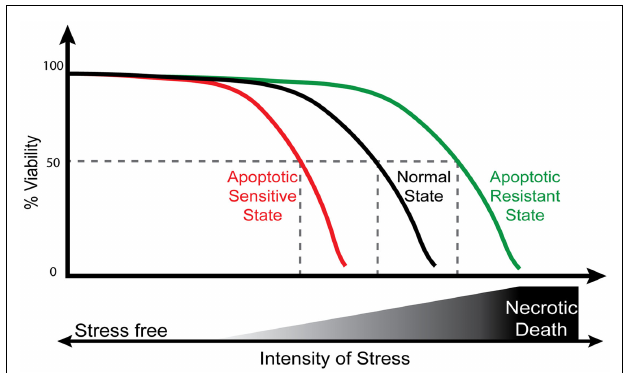
FIGURE 1 | Stress is a dose dependent mediator of cell death. A theoretical and graphical depiction of the effects of increasing the intensity of stress on cellular viability. In a stress free environment cellular viability is maintained close to 100% with only a basal level of cell death. In the normal state (depicted in black), the percentage of cell viability begins to decreases when a specific threshold of stress intensity is encountered. Intensity of stress reflects a combination of time of exposure to the stress and to its intensity. Cell death inducing stresses include a variety of different physical or chemical agents or pathophysiological stresses as discussed in the text. Once the threshold level of stress is encountered, the % viability further decreases in dose dependent manner with respect to the increase in the intensity of stress. In an apoptotic sensitive state (depicted in red), the minimal threshold of the intensity of stress that is required in order to observe a decrease in viability is reduced. Such an apoptotic sensitive state can be observed in cells that are lacking mechanism that are involved in apoptotic resistance such as the loss of an anti-apoptotic resistant gene or a mutation leading to defects in the induction of autophagy. Alternatively, overexpression of a pro-apoptotic gene can lead to a similar phenotype.The opposite phenotype, that is the state of apoptotic resistance (depicted in green), occurs in cells that are lacking some pro-apoptotic genes, that are overexpressing an anti-apoptotic gene or that have increased activation of other pro-survival processes such as autophagy.The net effect of altering a cell’s sensitivity to apoptosis can be observed in the different intensity of stress that is required to give rise to half maximal viability (50% viability, depicted by dashed lines).Thus the threshold of sensitivity to death inducing stress is variable and is established by complex regulatory processes that involve both pro- and anti-apoptotic processes. It should be noted that the processes that trigger apoptosis and that serve to induce cell death are not altered by the apoptotic resistant or sensitive